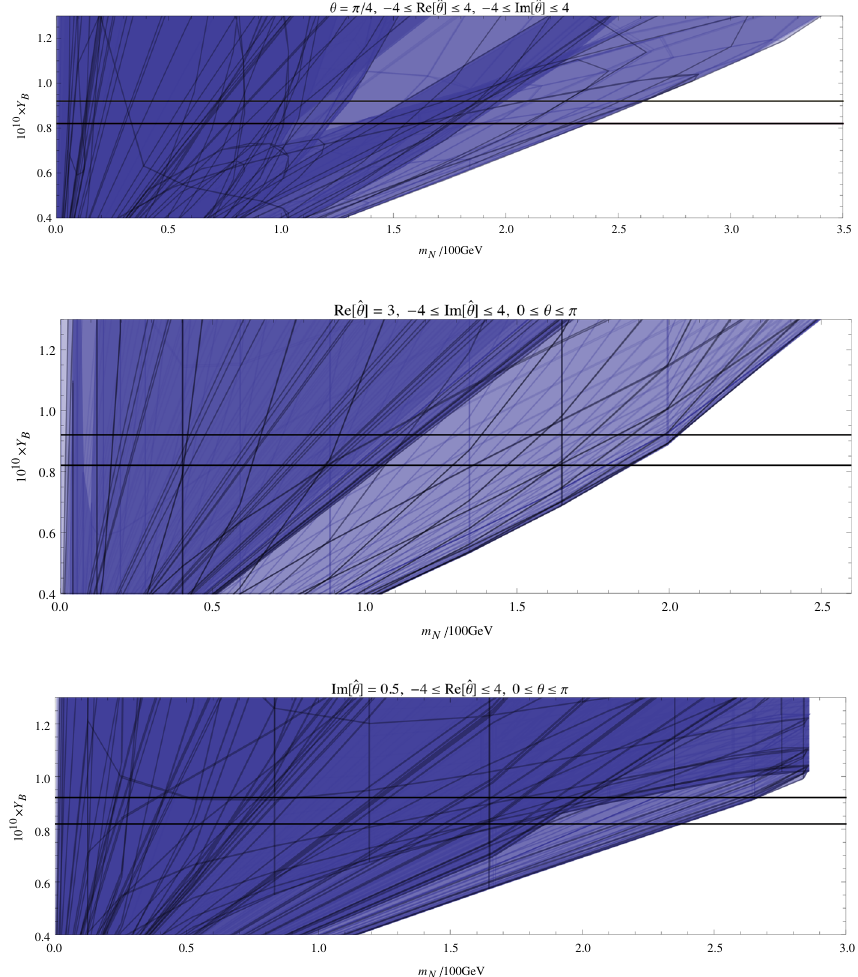
Fig. 2 Baryon asymmetry Y B and fermion dark-matter mass m N despited as the function of two CP-violating parameters determined in the ranges as shown on the top of each panel whereas the first CP-parameter is fixed